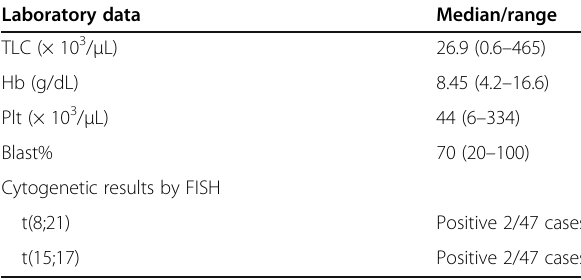
Table 1 Age and laboratory results of AML cases Laboratory